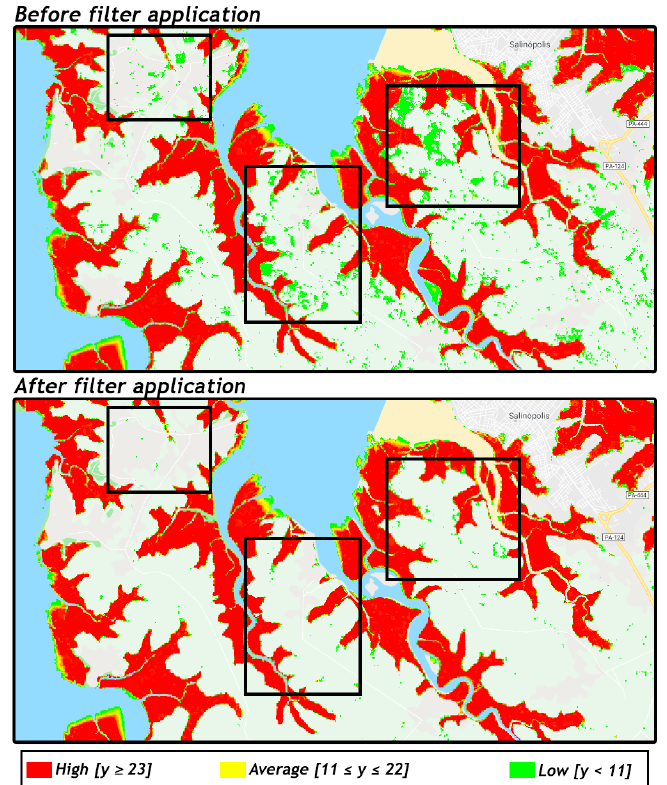
Figure 5. Red, yellow and green represent mangrove pixels with high (23 or more years, y ≥ 23), average (between 11 and 22 years, 11 ≤ y ≤ 22) and low (ten years or less, y < 11) occurrence frequencies, respectively. The top image shows mangrove pixels before applying the frequency filter. The bottom image shows mangrove pixels after applying the frequency filter. The black boxes are centred on areas that have been significantly affected by the filter. Note that all mangrove occurrences with less than 10% temporal persistence (3 years in 33 possible years) were filtered out.